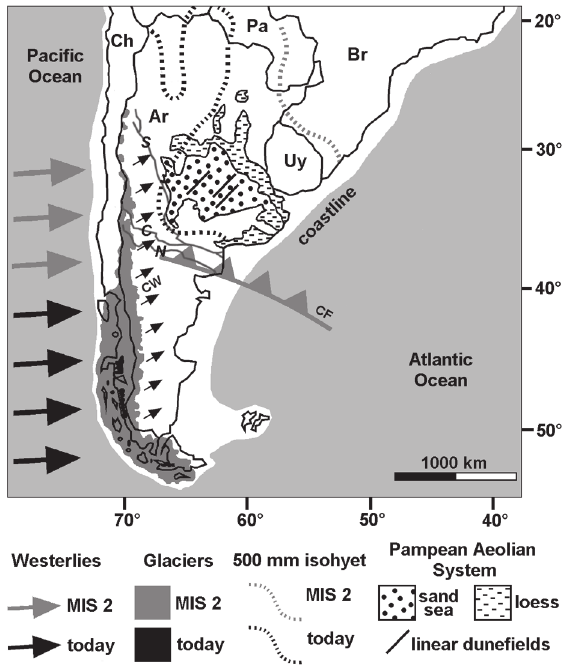
Figure 9 - Environmental conditions in southern South America during MIS 2: the combination of the northwards shifted Westerlies, increased cathabatic winds from the Andes (CW) and cold fronts (CF), resulted in cooling and enhanced aeolian processes, which promoted the northeasterly deflation of the Pampean loess generated in the Andes and distributed by the Salado ( S ), Colorado ( C ) and Negro ( N ) rivers. The coastline located some 100 km farther to the east increased the effects of continentality. These factors would have pushed semiarid conditions (limited by the 500 mm isohyet) some ~750 km to NE (Ar: Argentina, Br: Brazil, Ch: Chile, Pa: Paraguay, Uy: Uruguay; modified from Iriondo